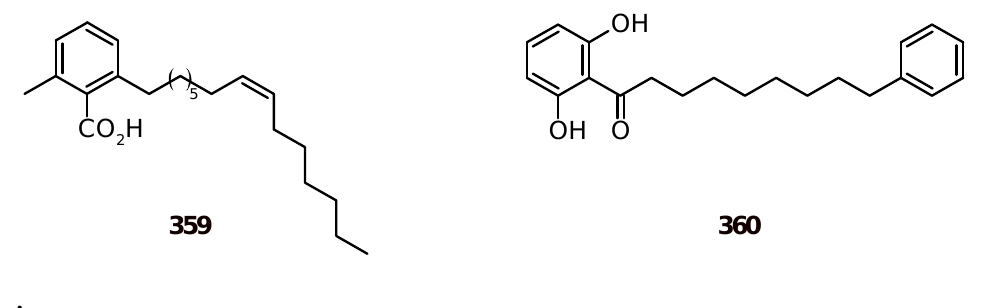
Figure 44. Structures of compounds 359 and 360